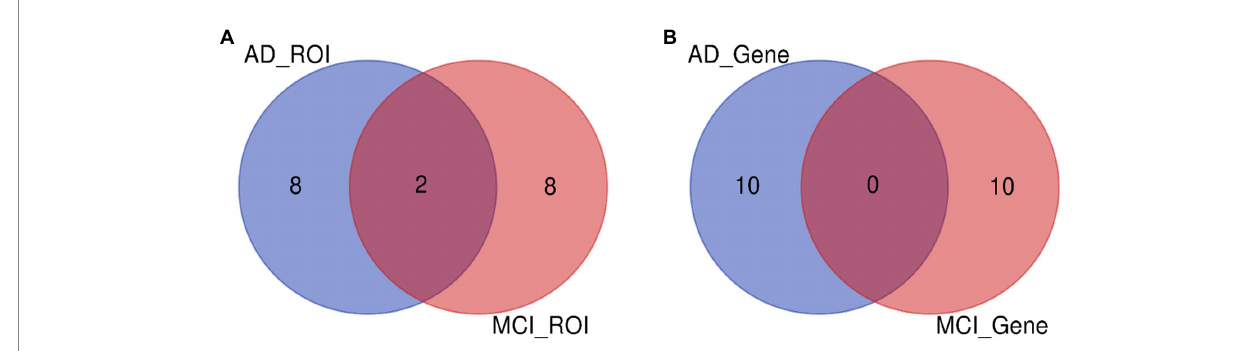
FIGURE 8 ROI and gene intersection of Top 10 in AD and MCI groups. (A) Is the intersection of ROI selected by AD group and MCI group. (B) Is the intersection of ROI selected by AD group and MCI group.